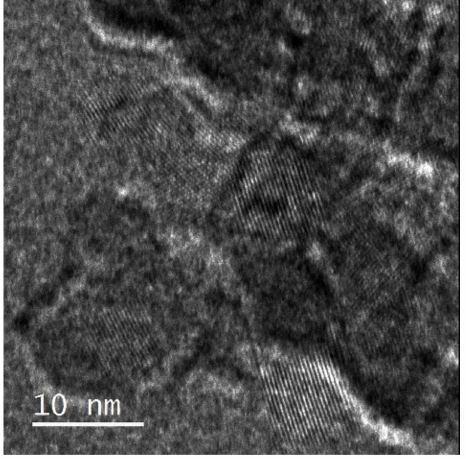
Figure A5. TEM micrograph of hydrothermally synthesized